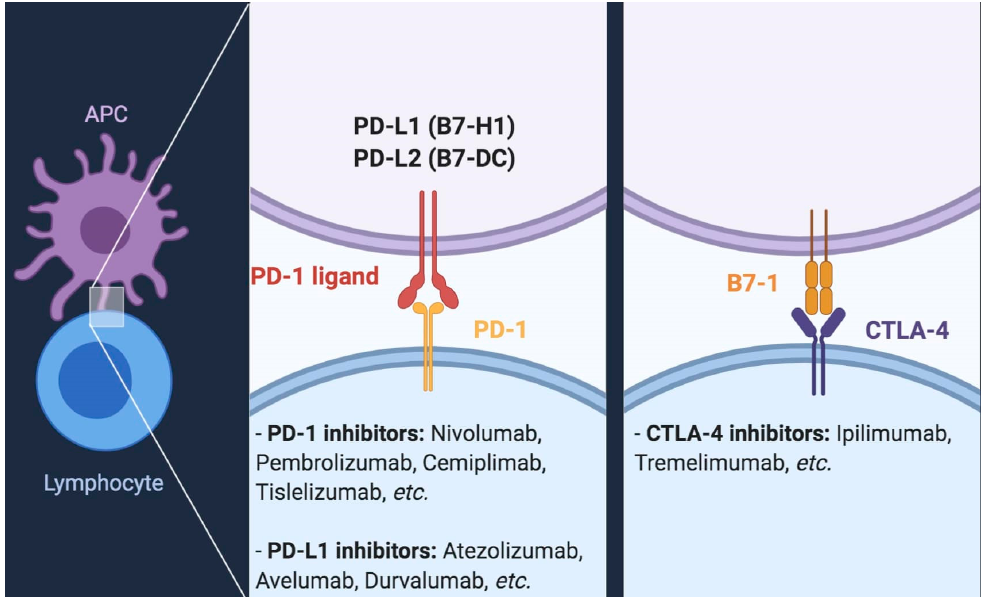
Figure 1. The interaction between PD-1 / PD-L1 and CTLA-4 / B7-1, a key mechanism exploited by immune checkpoint inhibitors. PD-1 inhibitors include nivolumab, pembrolizumab, cemiplimab, tislelizumab, and other agents currently in development; conversely, PD-L1 inhibitors encompass agents such as atezolizumab, avelumab, durvalumab, while CTLA-4 inhibitors encompass ipilimumab and tremelimumab.